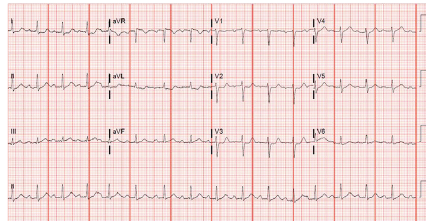
Figure 1: Electrocardiogram on admission demonstrates 1 mm ST segment depression in leads I, aVL, V2, and V3.